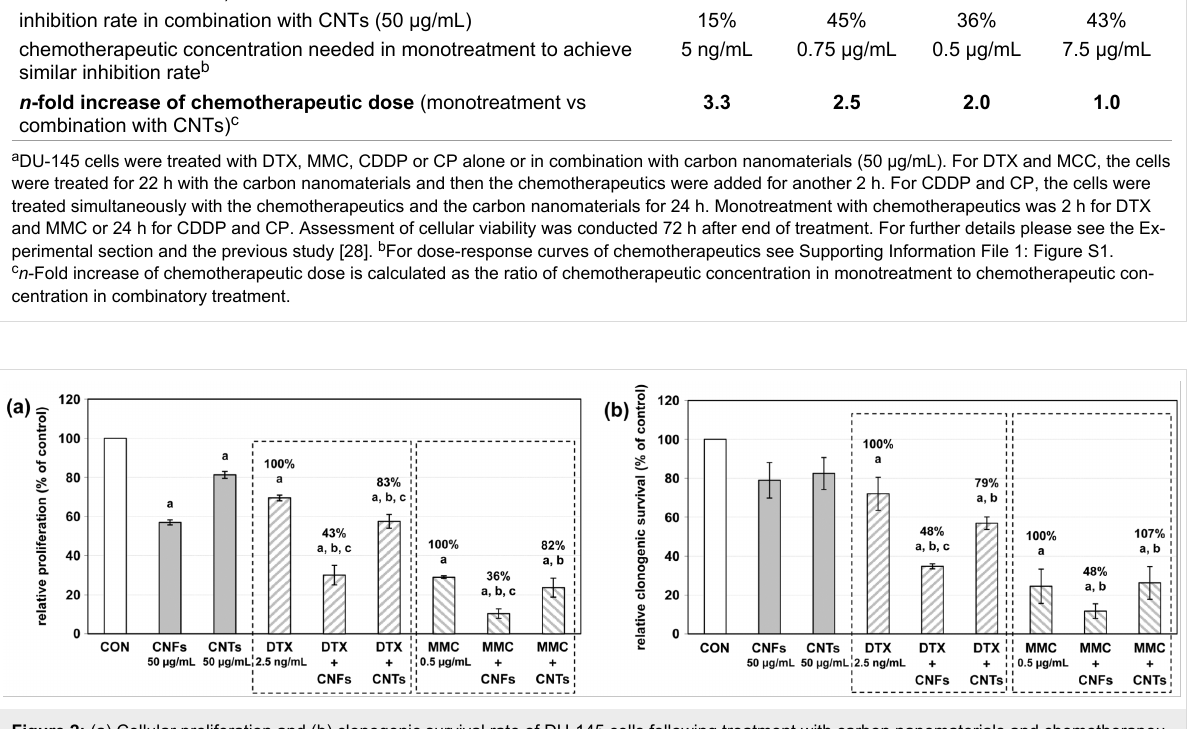
Figure 2: (a) Cellular proliferation and (b) clonogenic survival rate of DU-145 cells following treatment with carbon nanomaterials and chemotherapeu- tics alone or in combination. Combinatory treatments contained the respective carbon nanomaterial and chemotherapeutic in the same concentra- tions as indicated for the individual treatments. Results are depicted as averaged relative cellular proliferation or clonogenic survival (%) ± relative mean deviation. Untreated cells (CON) served as control (100%). a p < 0.05 treatment versus control; b p < 0.05 treatment versus carbon nanomaterial alone; c p < 0.05 treatment versus chemotherapeutic